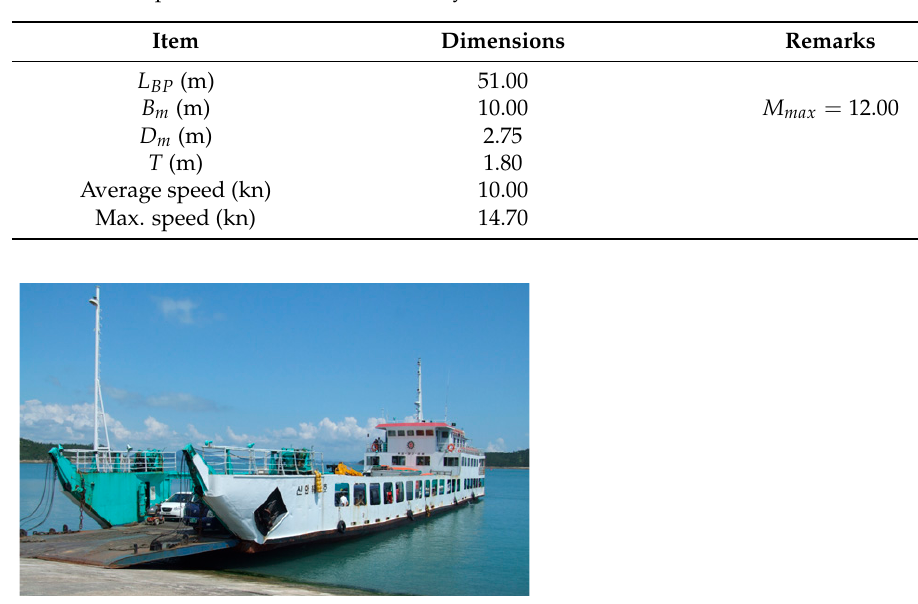
Table 3. Principal dimensions of Shinan Ferry No.5.